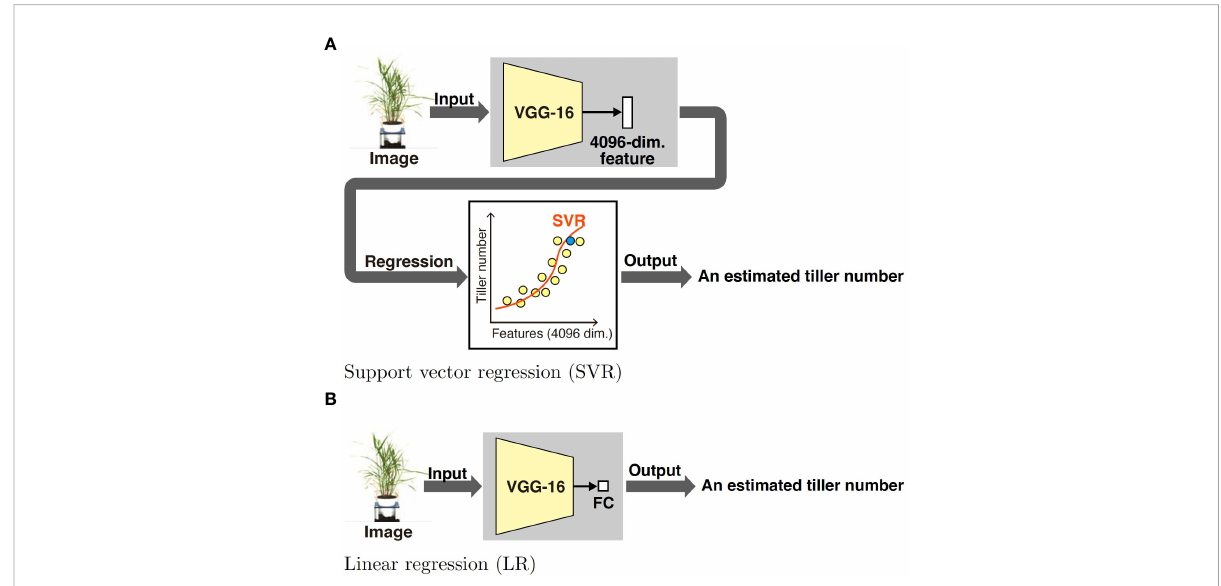
FIGURE 2 We propose two tiller number estimation methods using different regression models: support vector regression (SVR) and linear regression (LR). Both methods use the pretrained DNN model in Figure 1; more speci fi cally, we use the pretrained the VGG-16 model. In both methods, a plant image taken from the side is used for estimating the number of tillers. In SVR, a 4096-dimensional feature is extracted from the input image using the pretrained DNN. The parameters of SVR are estimated using features extracted from labeled images; the features and tiller numbers are used as independent and dependent values, respectively. In LR, a new FC layer consisting of an element is prepared. Using labeled images, the DNN is trained. Then, the DNN outputs an estimated tiller number for an input unlabeled